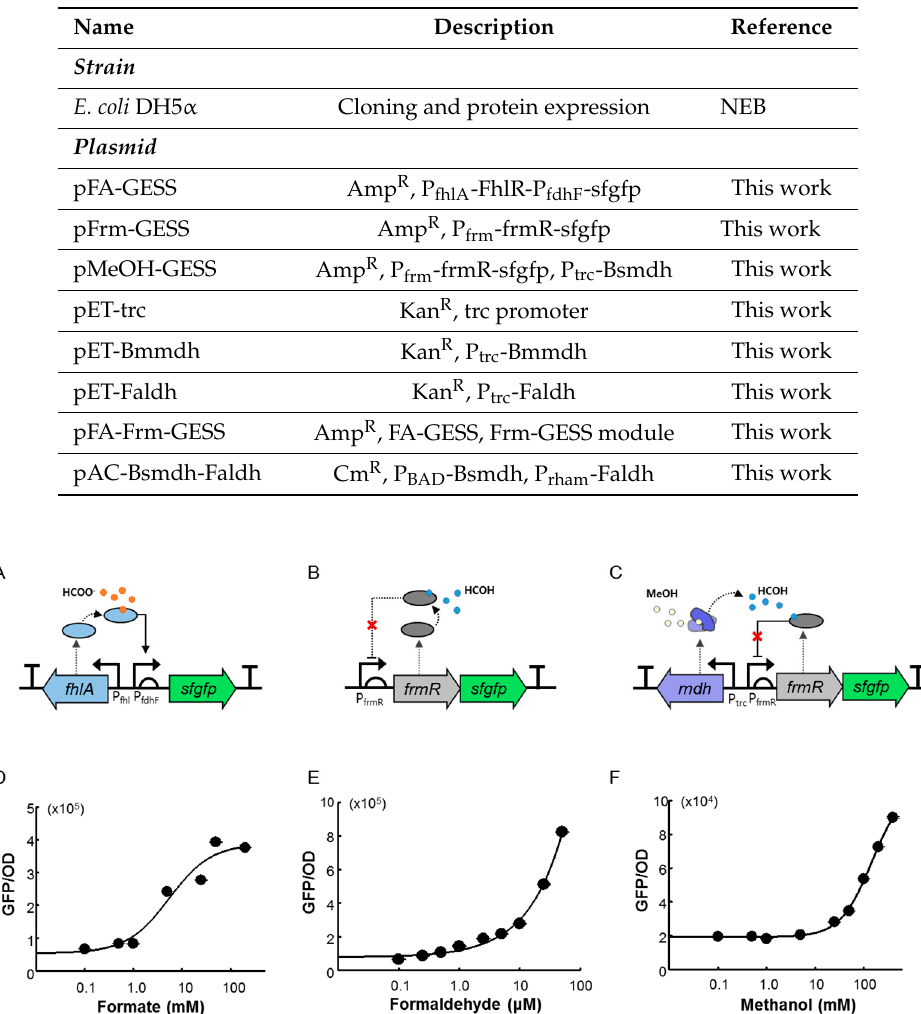
Table 1. E. coli strains and plasmids used in this